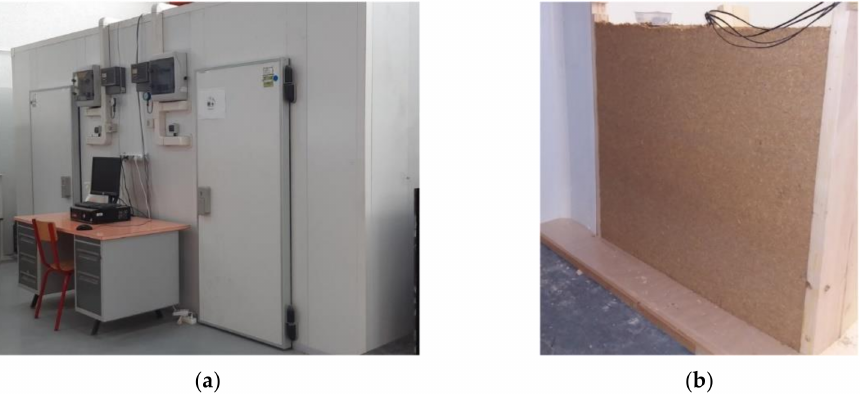
Figure 1. Experimental device ( a ), WFH wall ( b